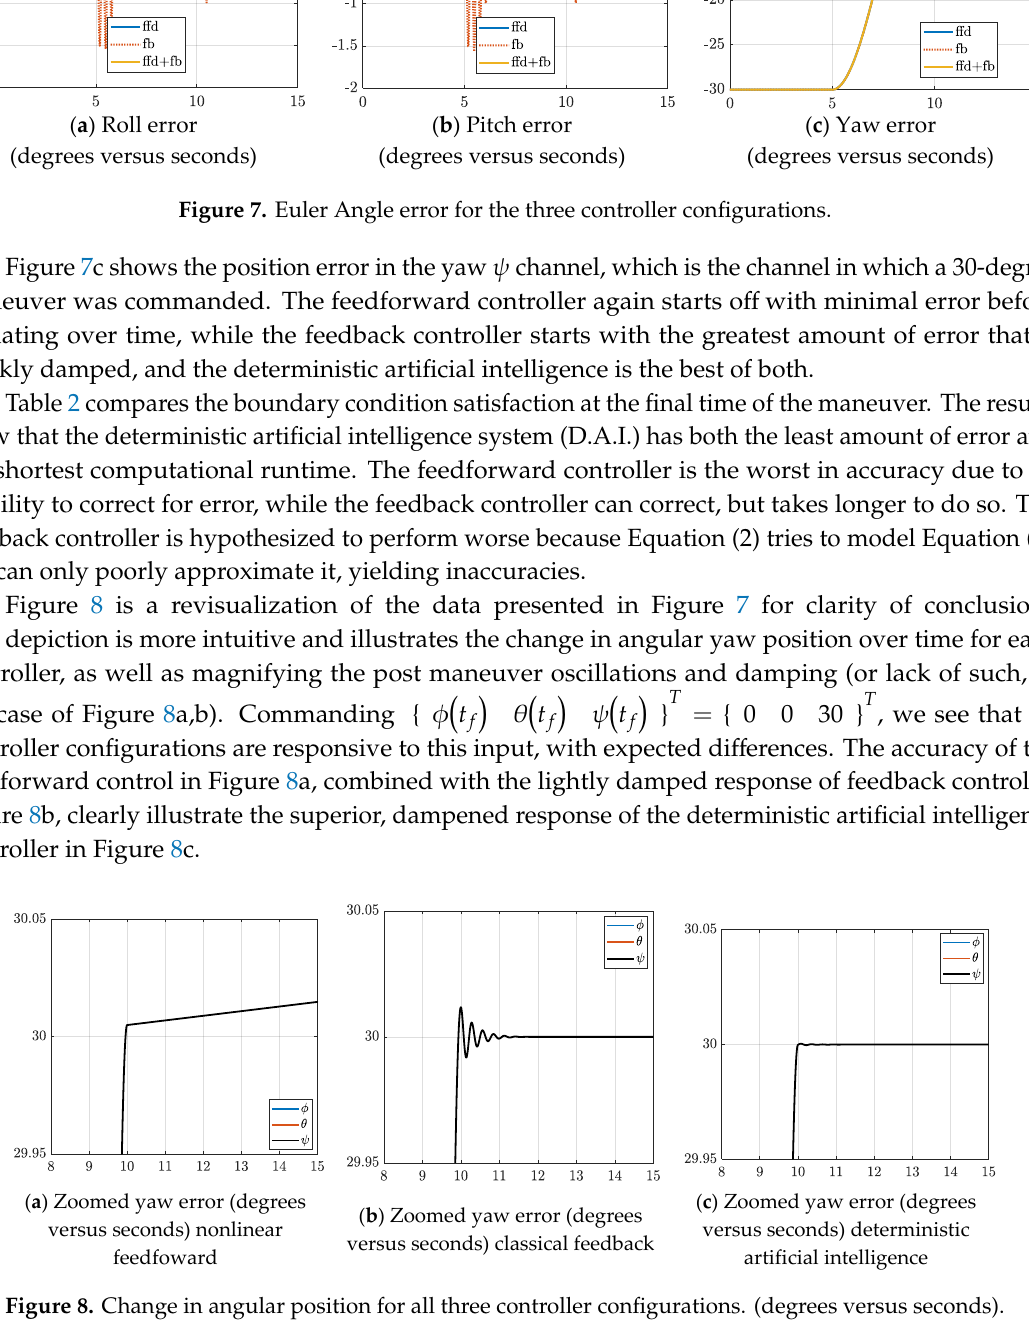
Figure 7. Euler Angle error for the three controller configurations.